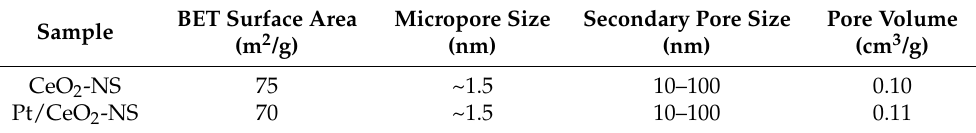
Table 1. Specific surface area, pore size, and pore volume of CeO 2 -NS and Pt/CeO 2